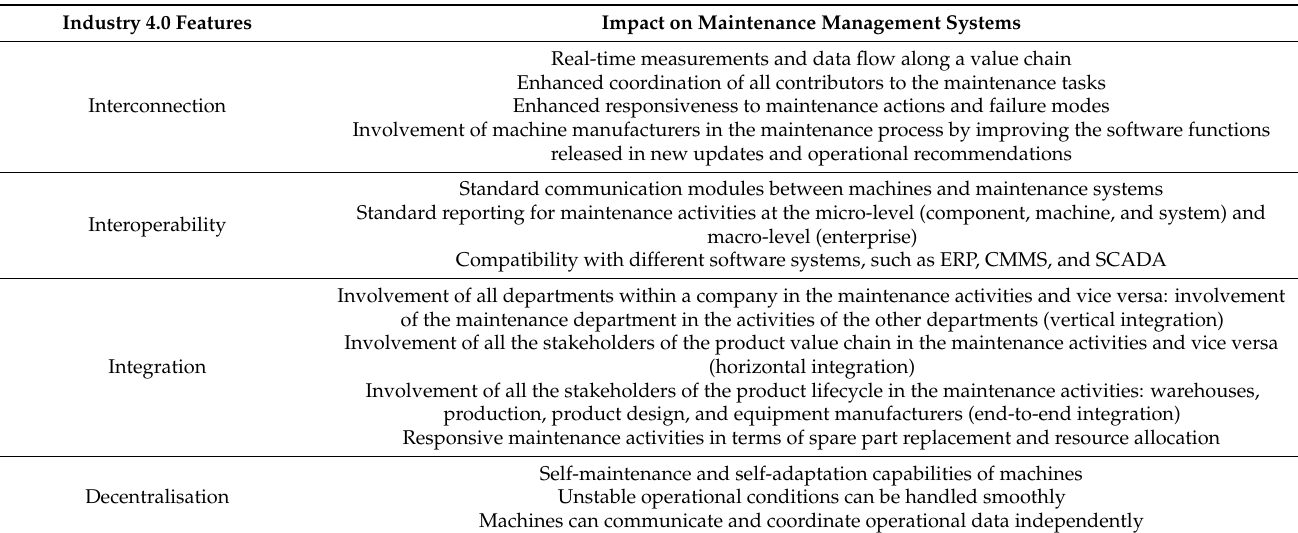
Table 5. Impact of Industry 4.0 features on maintenance management systems. Source: Authors’ elaboration. Industry 4.0